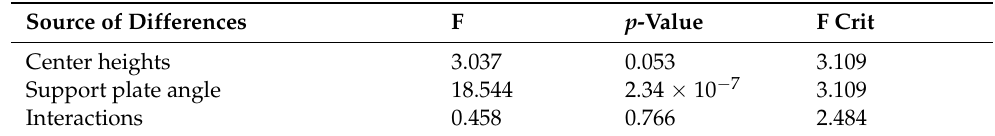
Table 4. Two-way ANOVA with